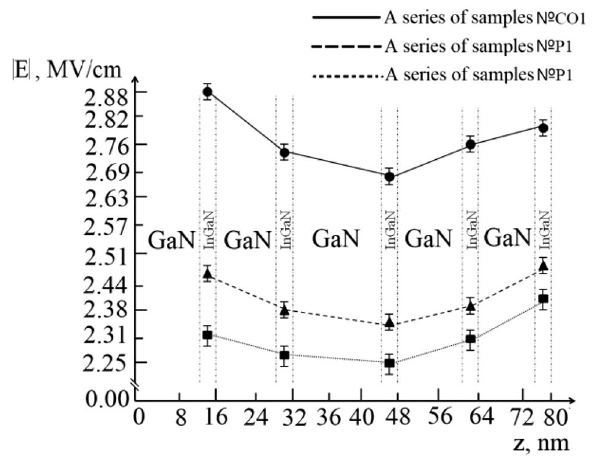
Fig. 7 Distribution of electric field superposition tension value along the active InGaN/AlGaN/GaN heterostructure